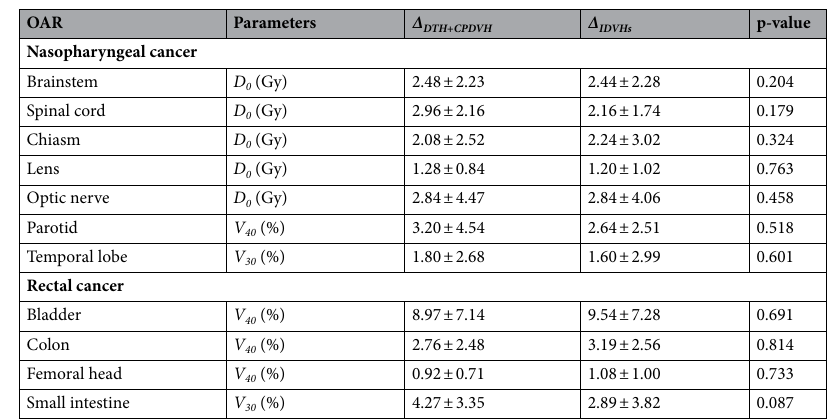
Table 4. Mean absolute difference between the dosimetric parameter achieved by the TPS and the dosimetric parameter predicted by the DTH + CPDVH or IDVHs method. For the DTH + CPDVH method, the prediction method in the testing cases. P represents the corresponding parameter. The data shown are the means and standard deviations of the respective parameters for the 20 nasopharyngeal cancer and 15 rectal cancer test